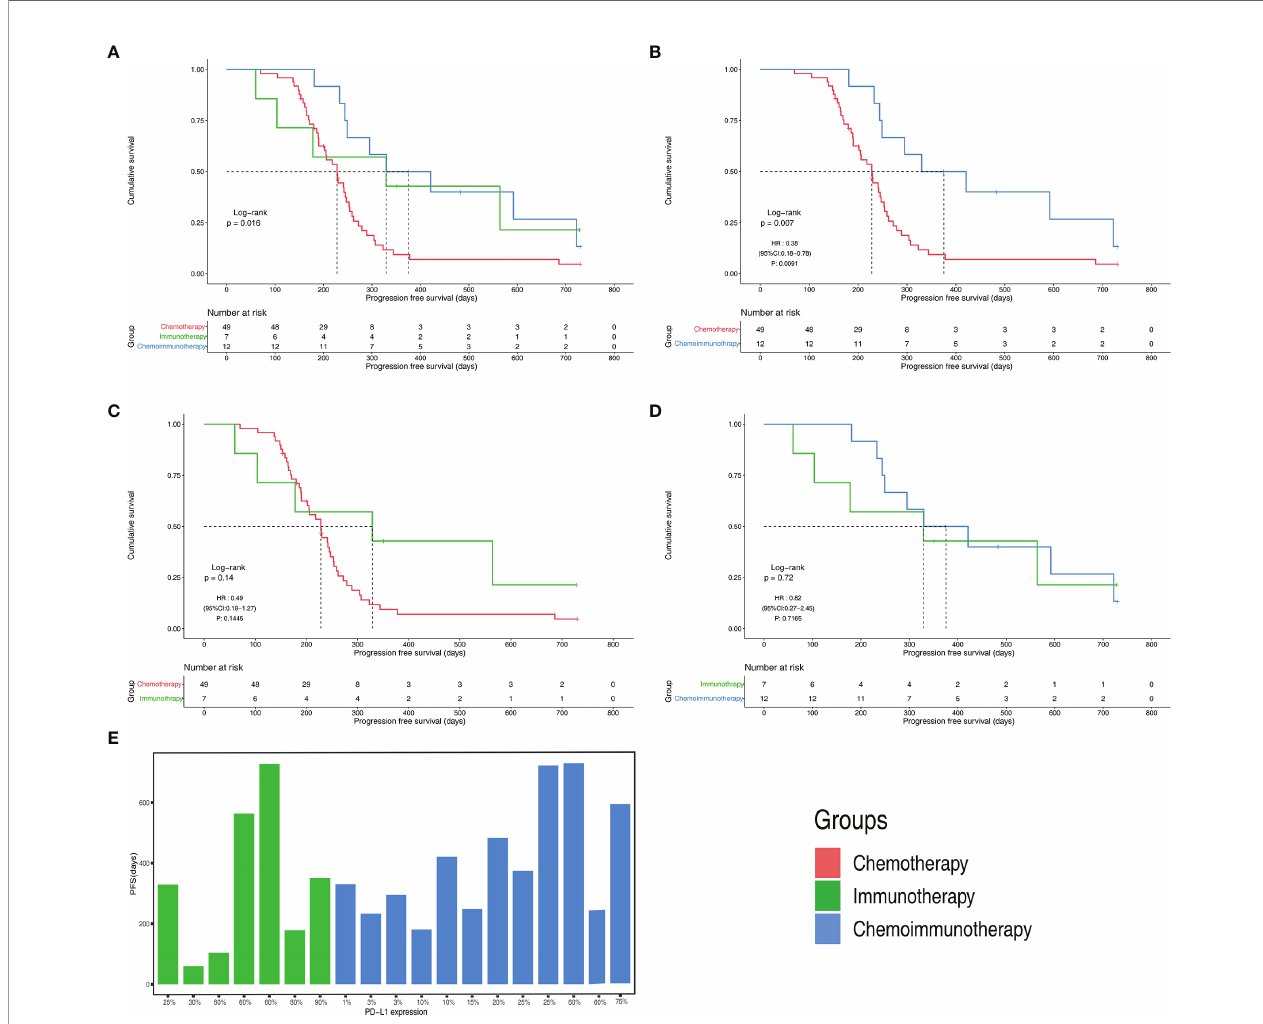
FIGURE 4 | Progression free survival(PFS) of different groups (A) PFS Kaplan-Meier curves of chemotherapy, immunotherapy and chemoimmunotherapy groups (B) PFS Kaplan-Meier curves of chemotherapy group and chemoimmunotherapy groups (C) PFS Kaplan-Meier curves of chemotherapy group and immunotherapy groups (D) PFS Kaplan-Meier curves of immunotherapy and chemoimmunotherapy groups (E) PFS with different PD-L1 expression in immunotherapy and chemoimmunotherapy groups. CI, con fi dence interval; HR, hazard